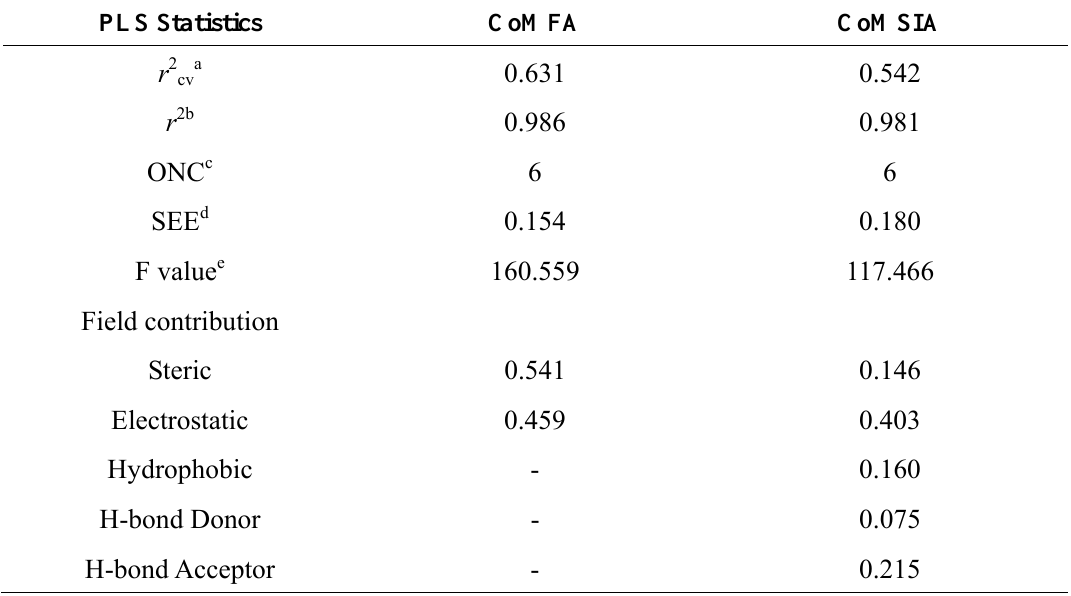
Table 3. PLS results of CoMFA and CoMSIA models.